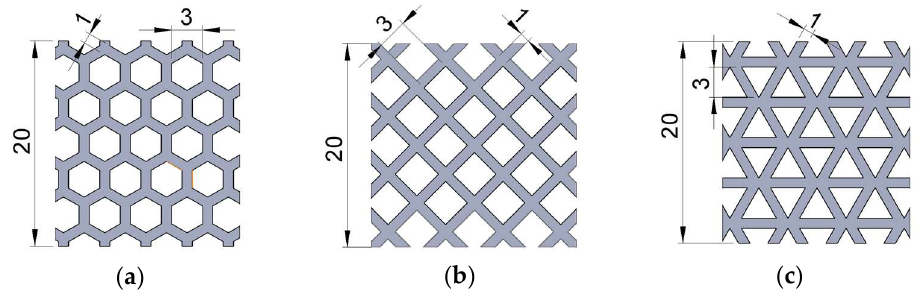
Figure 6. The detailed views of structures’ cells: ( a ) hexagonal, ( b ) grid, ( c ) triangles. To compare the mechanical behavior of the three structures, the differences in actual volume (reflecting material consumption) were calculated, based on the 3D models from SolidWorks (Table 1). The volume of the grid structure is 1.82% smaller compared to the hexagonal structure, while the volume of the triangular structure is 23.96% higher. Table 1. The comparative analysis of volume for the three specimens.